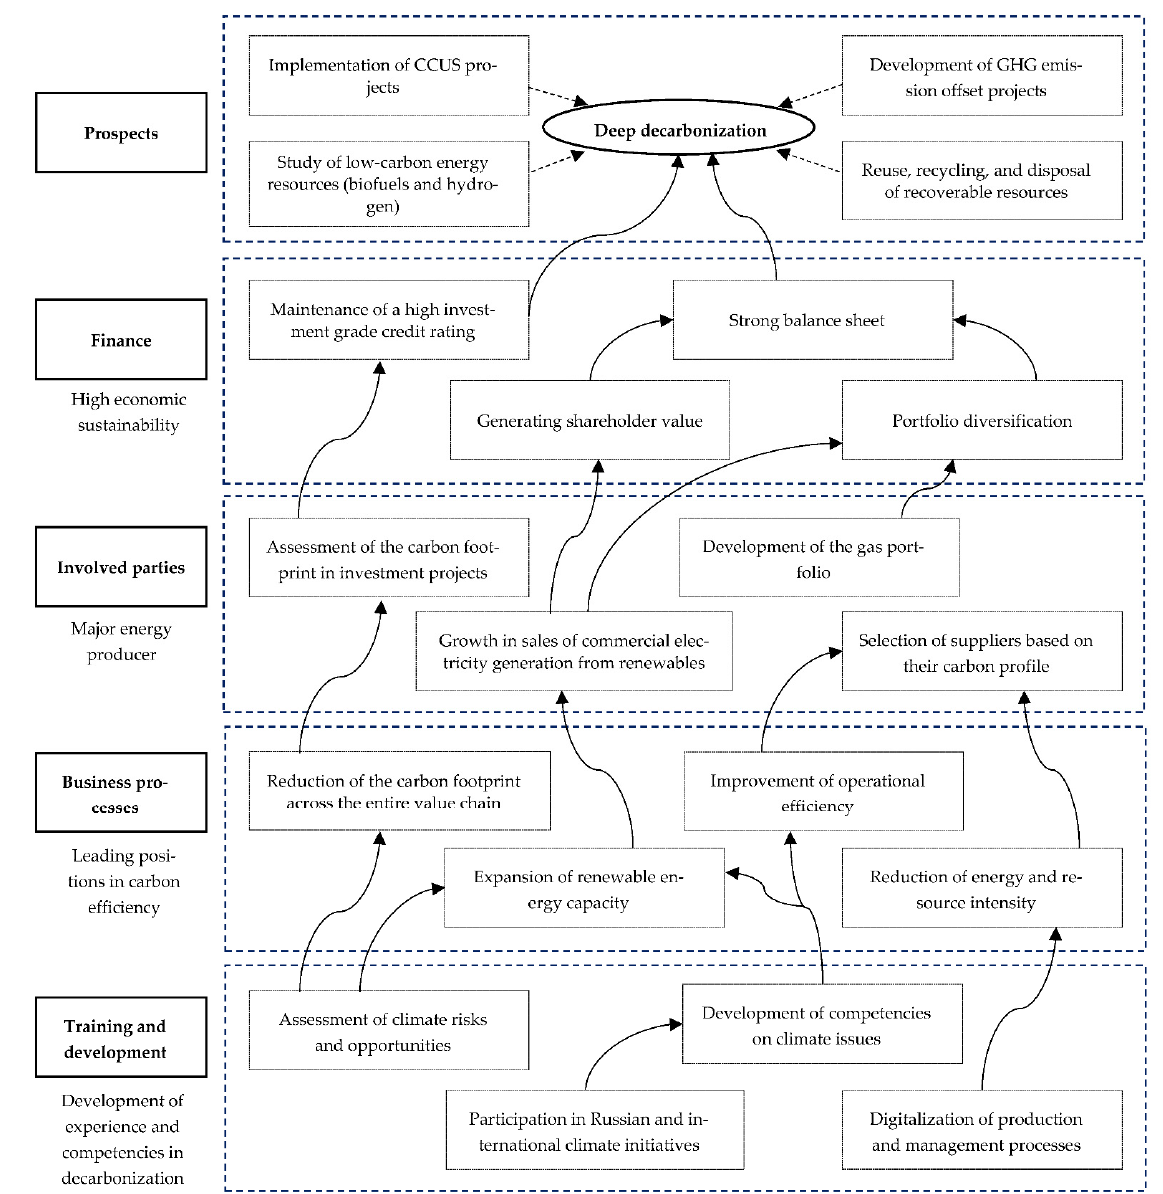
Figure 7. Strategic map of climate adaptation for LUKOIL. Source: Created by the authors with the use of [94,95] .